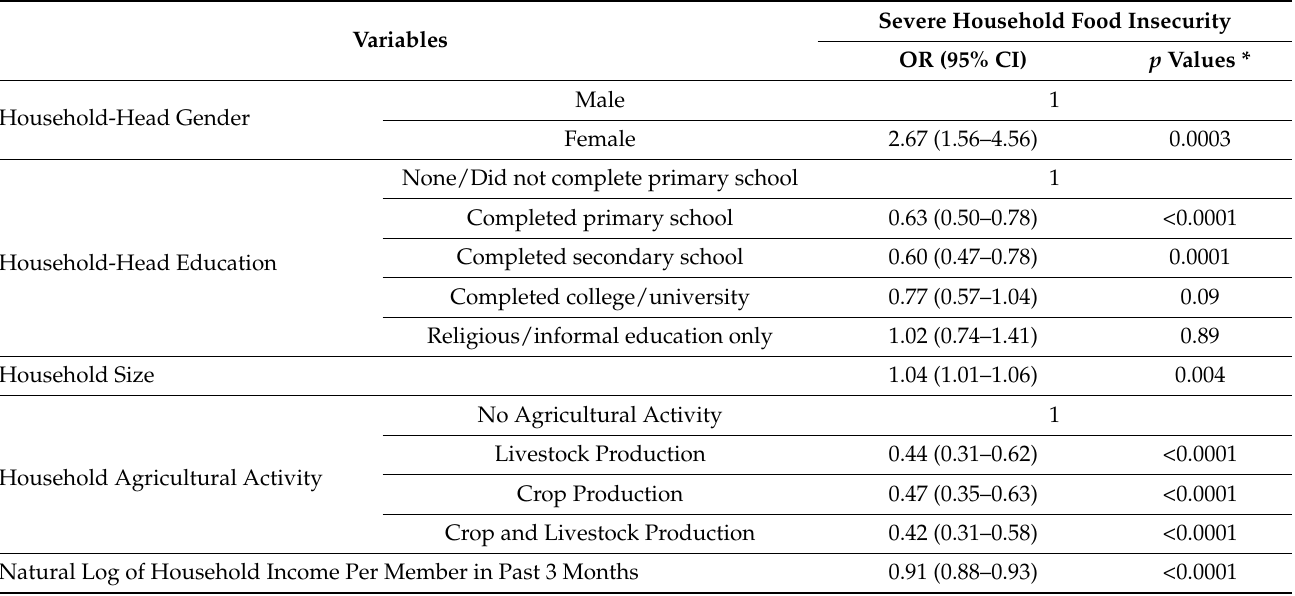
Table 3. Univariate analysis of social determinants of severe household food insecurity.